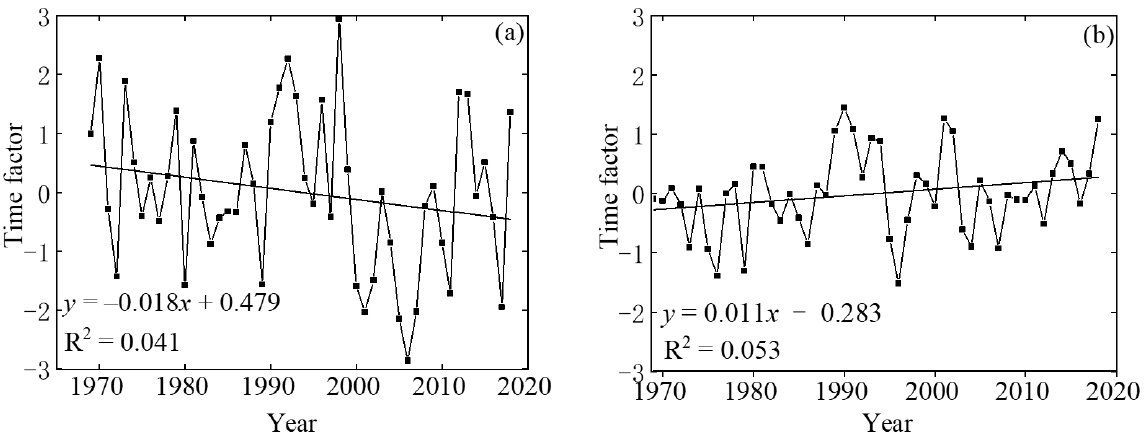
Figure 7. The time coefficients corresponding to the first two feature vectors of the EDI in 1969–2018. ( a ) Corresponding time coefficients for the first mode of EOF; ( b ) corresponding time coefficients for the second mode of